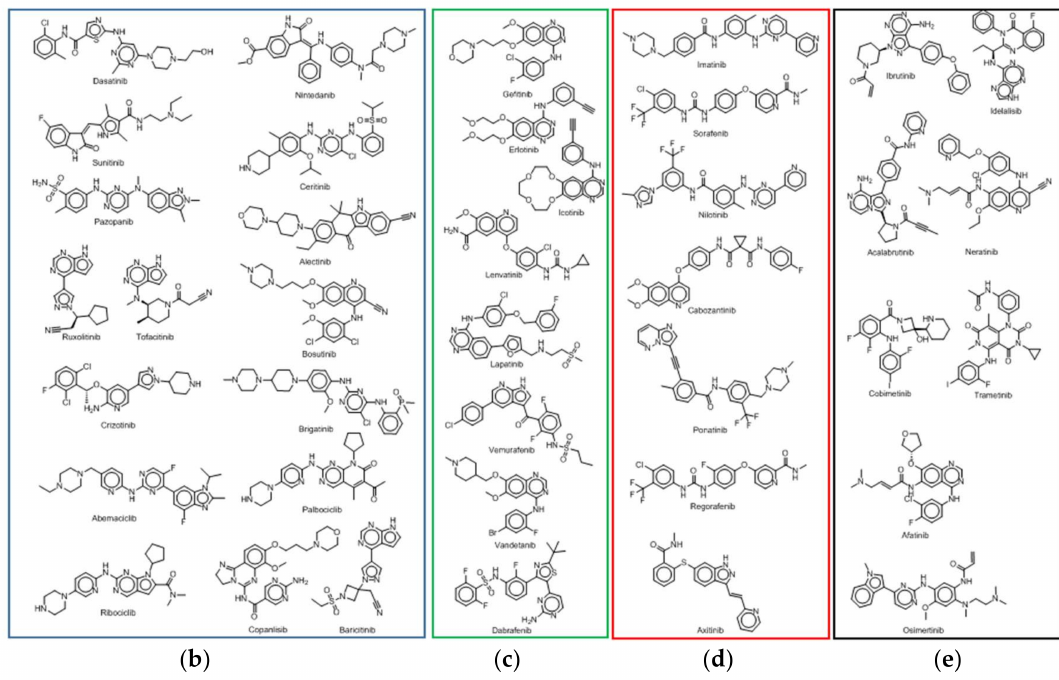
Figure 1. FDA-approved kinase inhibitors. Icotinib and baricitinib are approved by CFDA (China Food and Drug Administration) and by EMA (European Medicines Agency) respectively: ( a ) evolution of approved protein kinase inhibitors (2001–2017); ( b ) Structures of Type-I PKIs; ( c ) Structures of Type-I 1 / 2 PKIs; ( d ) Structures of Type-II PKIs; ( e ) Structures of Type-I covalent inhibitors (ibrutinib, afatinib, osimertinib, neratinib, acalabrutinib), Type-III inhibitors (trametinib and cobimetinib) and PI3K lipid kinase inhibitor